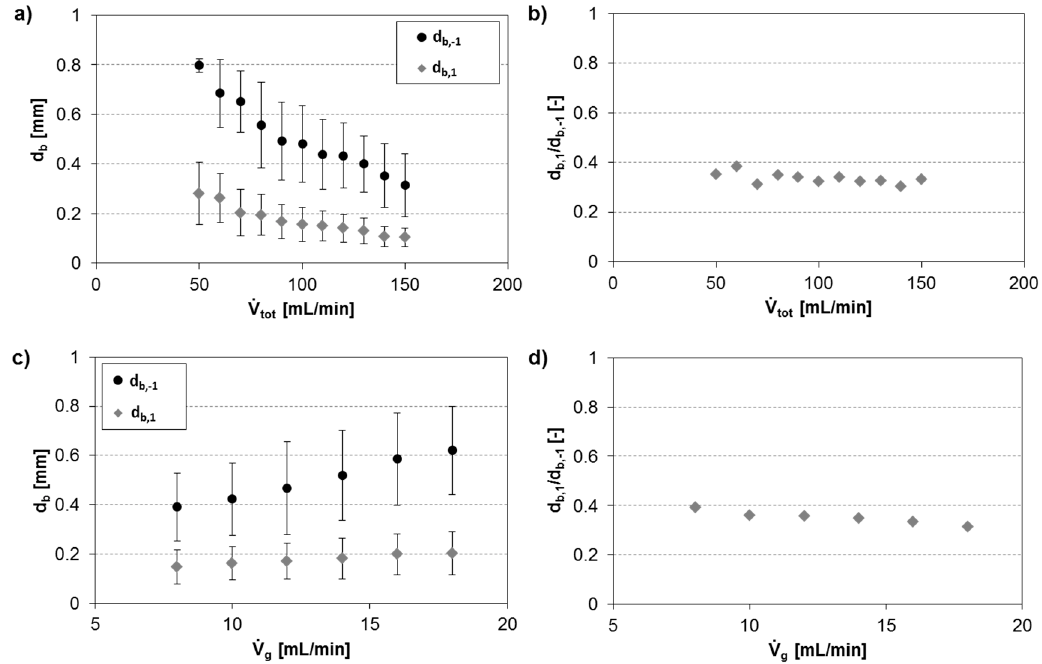
Figure 10. Influence of mother bubble size on daughter bubble size. The top row diagrams ( a , b ) show results for constant void fraction ϕ = 10% and varied total volumetric flow rate. The bottom row diagrams; ( c , d ) show same diagrams for constant liquid flow rate (cid:1848)(cid:4662) (cid:3039) = 100 mL/min and flow varied gas flow rate.